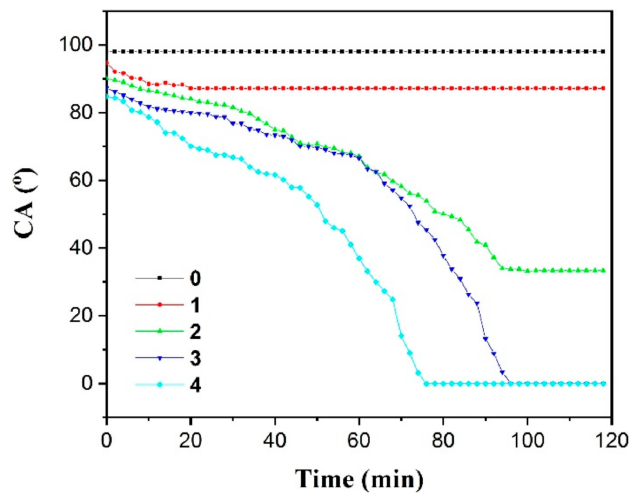
Figure 8. Dynamic contact angle versus time curves of PP and its H-PAAS